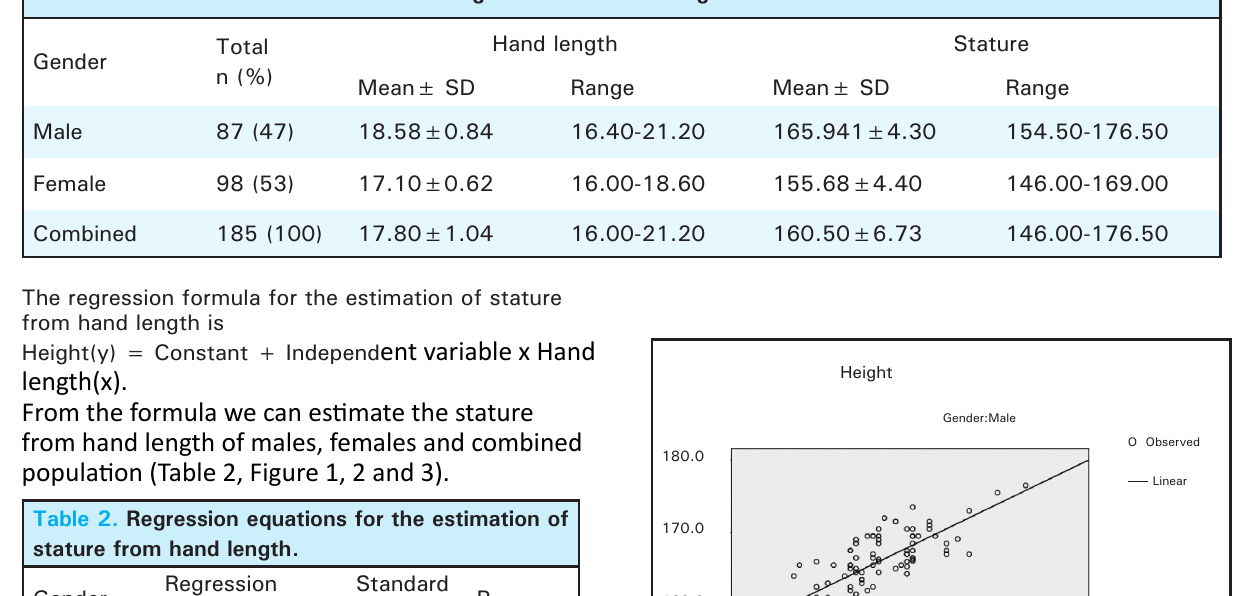
Table 1. Mean and S.D. for hand bone length and stature among male and female students.